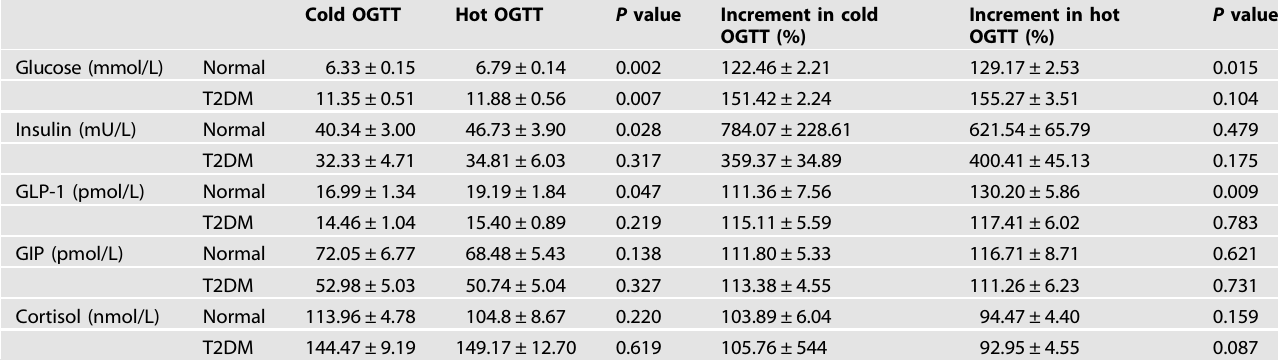
Table 2. Measurements after cold and hot OGTTs with ANOVA (repeated measures).